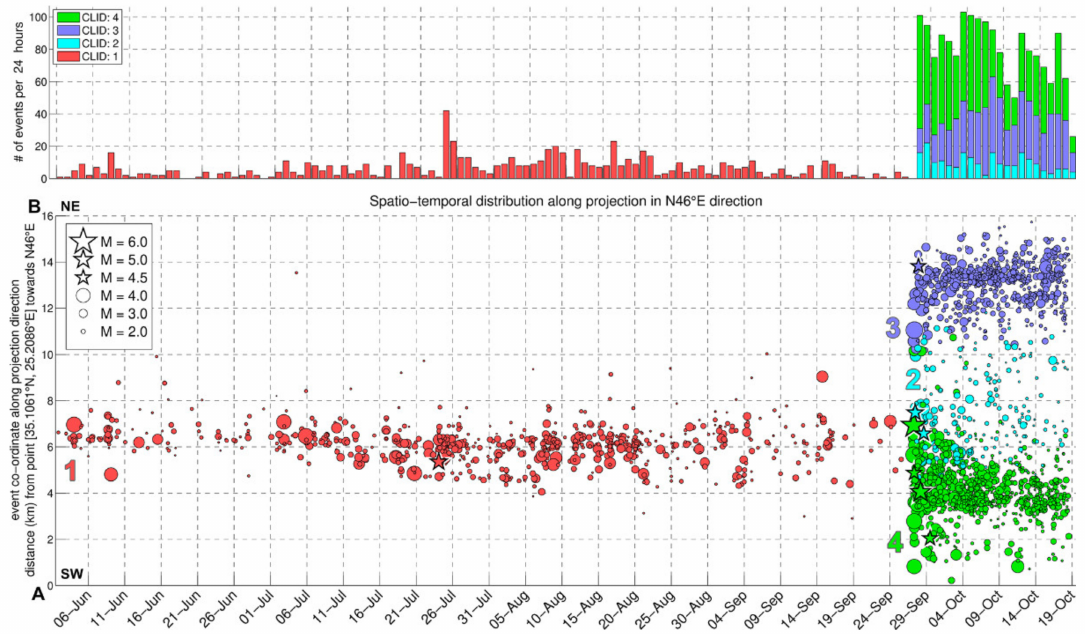
Figure 9. ( Top ) Stacked histogram of the number of seismic events per day in the study area between 1 June and 18 October 2021. ( Bottom ) Spatiotemporal projection along the SW-NE-oriented profile A-B of Figure 8b. Colors and numbers (CLID) represent groups 1–4 of Figure 8b. Events with M ≥ 4.5 are depicted as